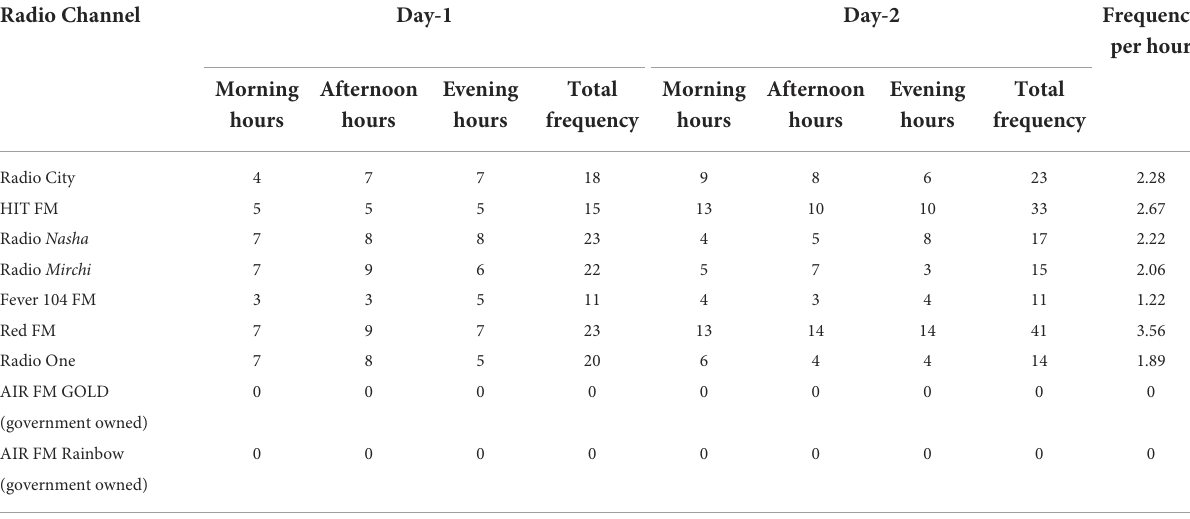
TABLE 1 Frequency of the surrogate advertisement broadcasted across different FM Radio channels selected in the present study. Radio Channel